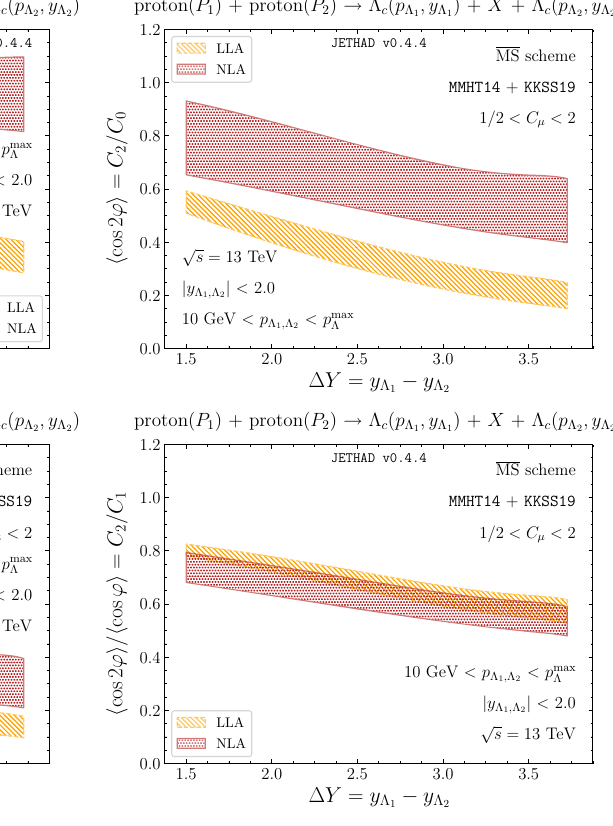
ing from scale variation and numerical integrations. Text boxes inside panels show transverse-momentum and rapidity ranges